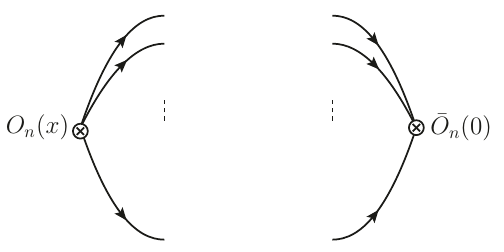
Figure 1 . The diagram representing the insertion of a chiral operator O n = tr (cid:30) n in x and of the corresponding anti-chiral operator O n = tr (cid:30) n in the